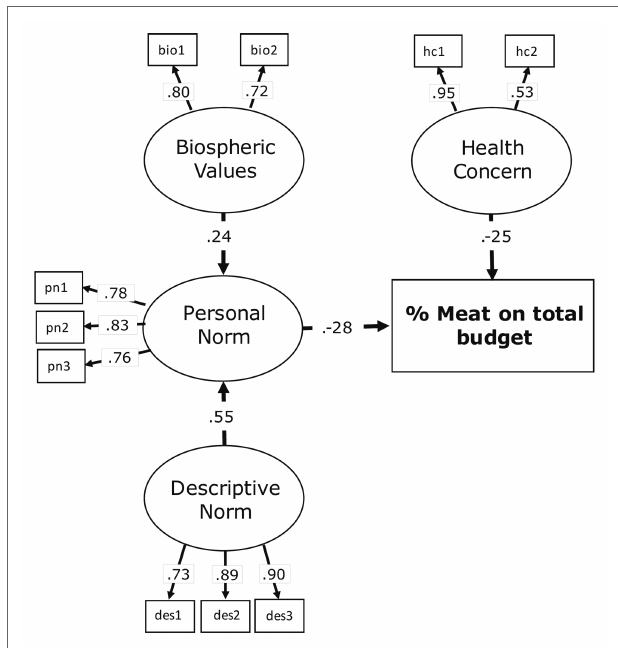
FIGURE 5 | Standardized direct effects and item loadings in the structural model of Study 2. To simplify presentation, the variances – curved double arrows – of the exogenous latent variables and the standardized error variances are not